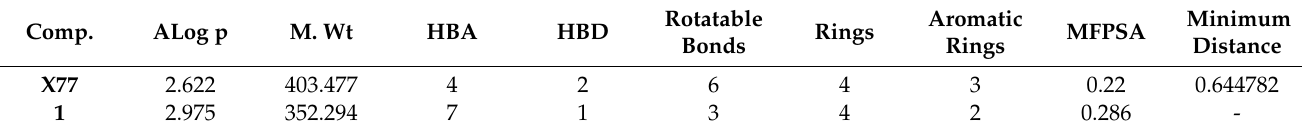
Figure 4. The chemical structures of the examined SARS-CoV-2 proteins ligands and jusan coumarin. The Discovery Studio software investigated the subsequent molecular descriptors in jusan coumarin and the examined ligands; the partition coefficient, ALog p, [70]; the molecular weight, M. W, [71]; the number of atoms that act as H- bond donors (HBD) [72]; and H- bond acceptors (HBA) [73]; the rotatable bonds numbers [74]; the aromatic rings numbers [75]; and the heterocyclic rings numbers [76] together with the molecular fractional polar surface area (MFPSA) [77]. The outputs demonstrated the great degree of similarity between jusan coumarin and the co-crystallized ligands ( X77 ) of SARS-CoV-2 main protease (PDB ID: 6W63) (Table 2 and Figure 5). Table 2. Structural properties of jusan coumarin with X77